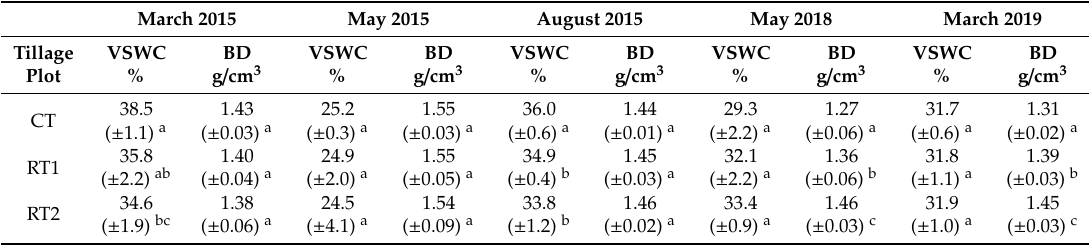
Table 3. Comparison of volumetric soil water content and bulk density after OTIT in a depth between 18 and 23